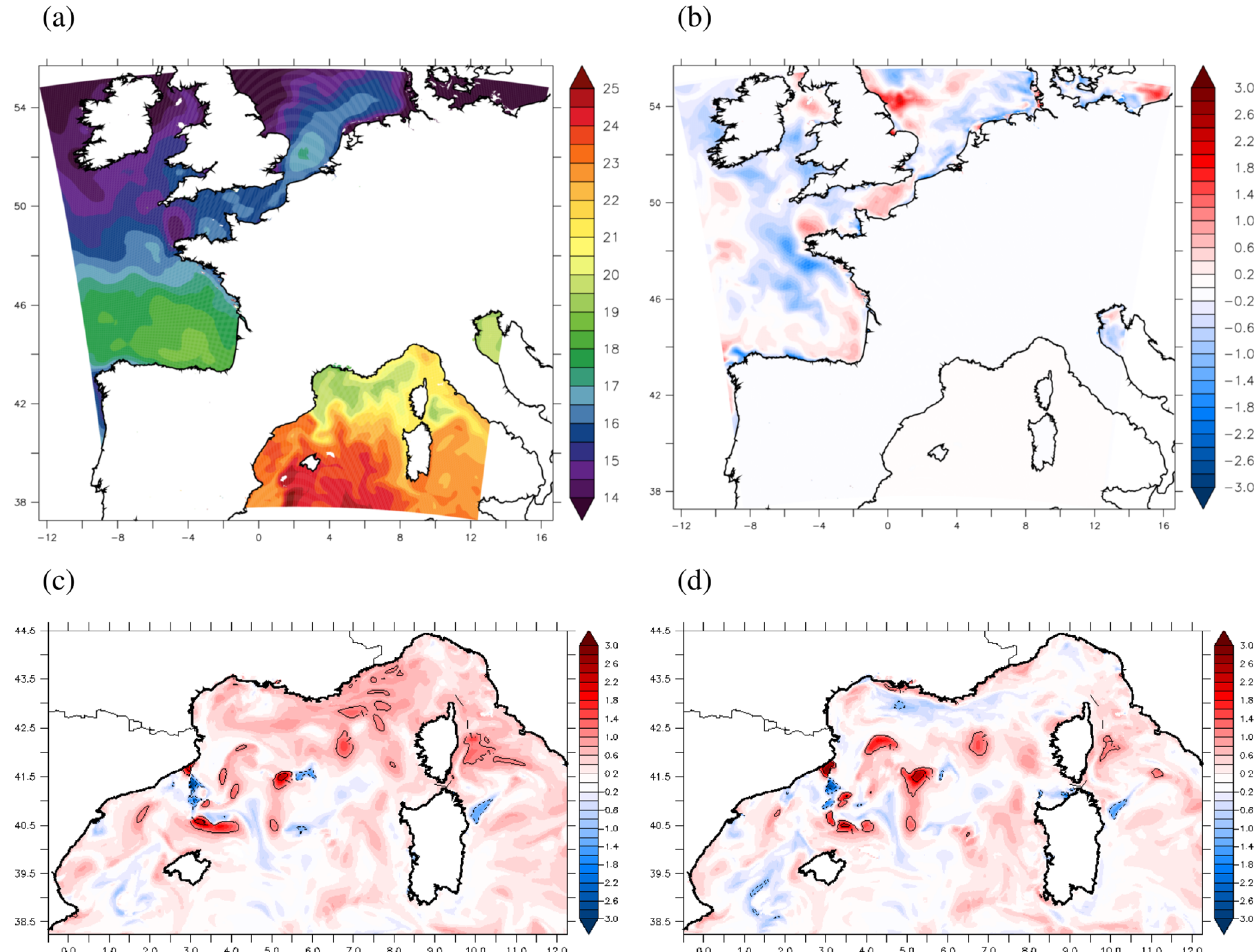
Figure 3. (a) SST ( ◦ C) forecast in AOW at 14:00UTC on 13 October (forecast basis: 13 October 00:00UTC) and (b) differences in initial SST fields ( ◦ C, 13 October 00:00UTC) between AY and AYSSTatl (AROME forecasts with persistent SST; see text and Table 2). Comparison of the AOW SST forecast (basis: 13 October 00:00UTC) over NWM (c) at 01:00UTC on 13 October and (d) at 00:00UTC on 14 October, with the PSY4 daily analysis of 13 October (used in AY/AYSSTatl/AW